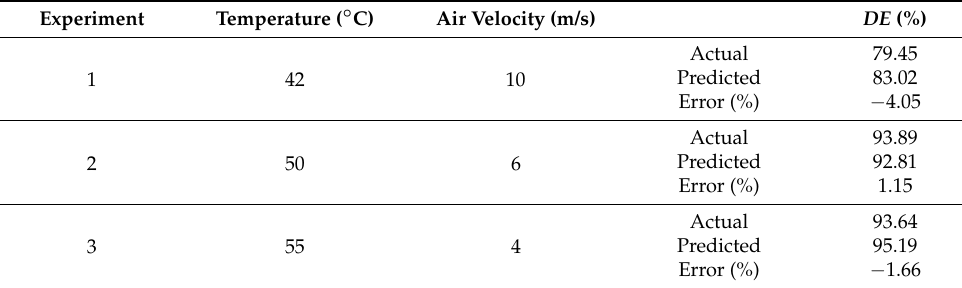
Table 3. Confirmation